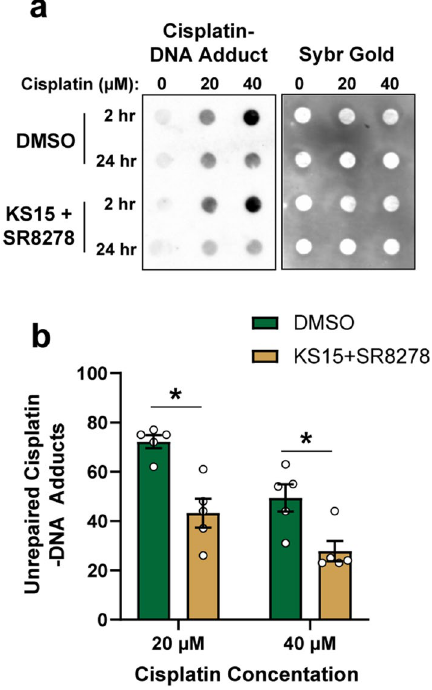
Figure 4. Treatment of cells with KS15 and SR8278 treatment promotes the removal of cisplatin–DNA adducts from genomic DNA. (a) U2OS cells were treated with DMSO vehicle or 20 µM KS15 + 10 µM SR8278 along with the indicated concentrations of cisplatin. Genomic DNA was purified from the cells 2 and 24 h later and analyzed by DNA immunoblotting with an anti-cisplatin DNA adduct antibody. Blots were then stained with SybrGold to visualize total DNA. (b) Quantitation of relative cisplatin–DNA adduct signal (average and SEM) at 24 h in relative to the 2 h time point (n = 5). The asterisks indicate significant differences in unrepaired cisplatin adducts (t-test, p <